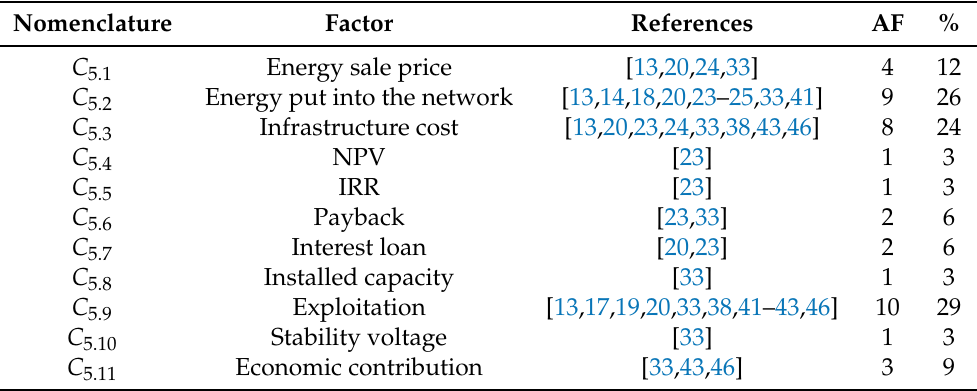
Table 11. Economics Category ( C 5 )—Onshore wind energy. Quantitative